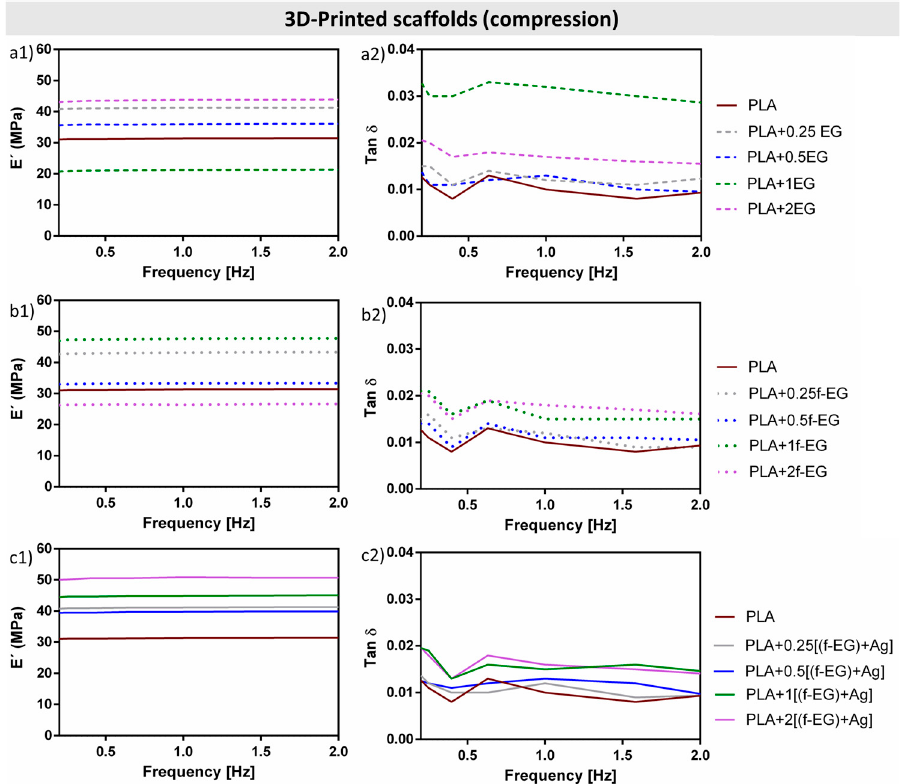
Figure 10. ( a1 – c1 ) Storage modulus (E ′ ) of 3D-printed scaffolds reinforced with EG, f-EG, and [(f-EG)+Ag], respectively, and ( a2 – c2 ) the corresponding loss factor (tan δ ), as a function of the frequency, ranging from 0.1 to 2 Hz. Three-dimensional printed scaffolds were tested in compression mode.